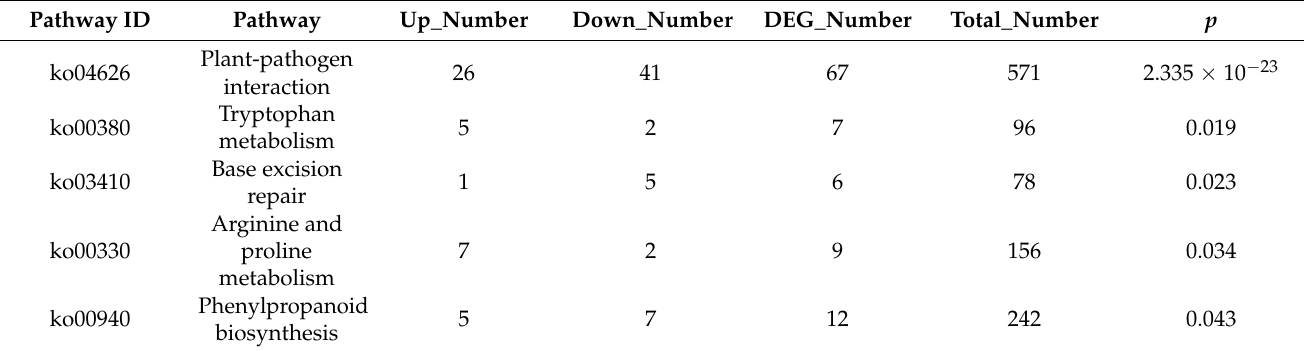
Table 5. KEGG enrichment analysis based on DEGs in the comparison of QLCK vs. RACK.